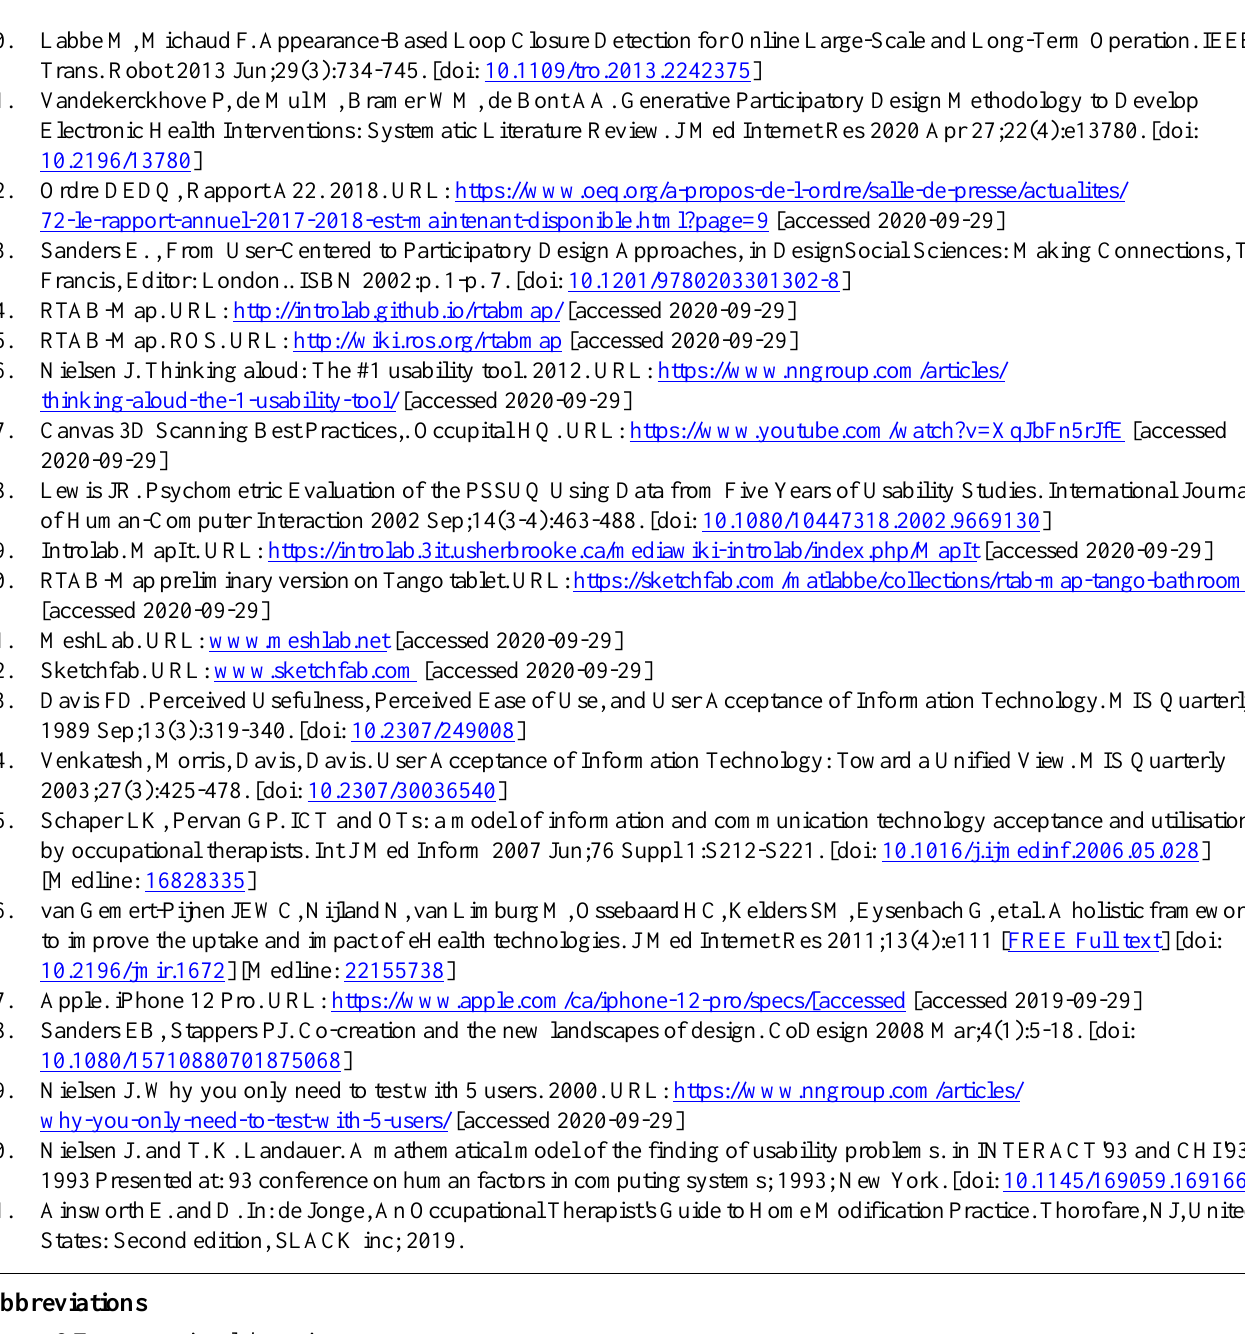
RTAB-Map: Real-Time Appearance-Based Mapping SLAM: Simultaneous Localization and